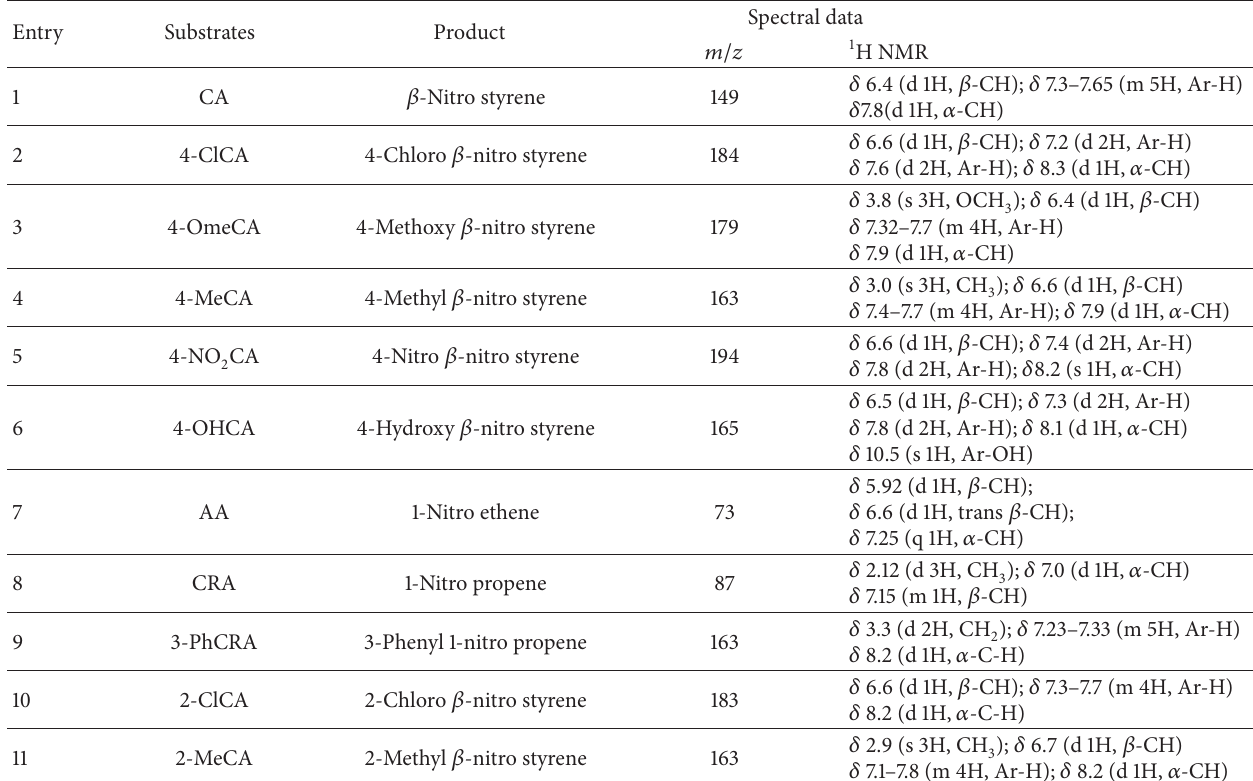
Table 2: NMR and mass spectral data for selected reaction